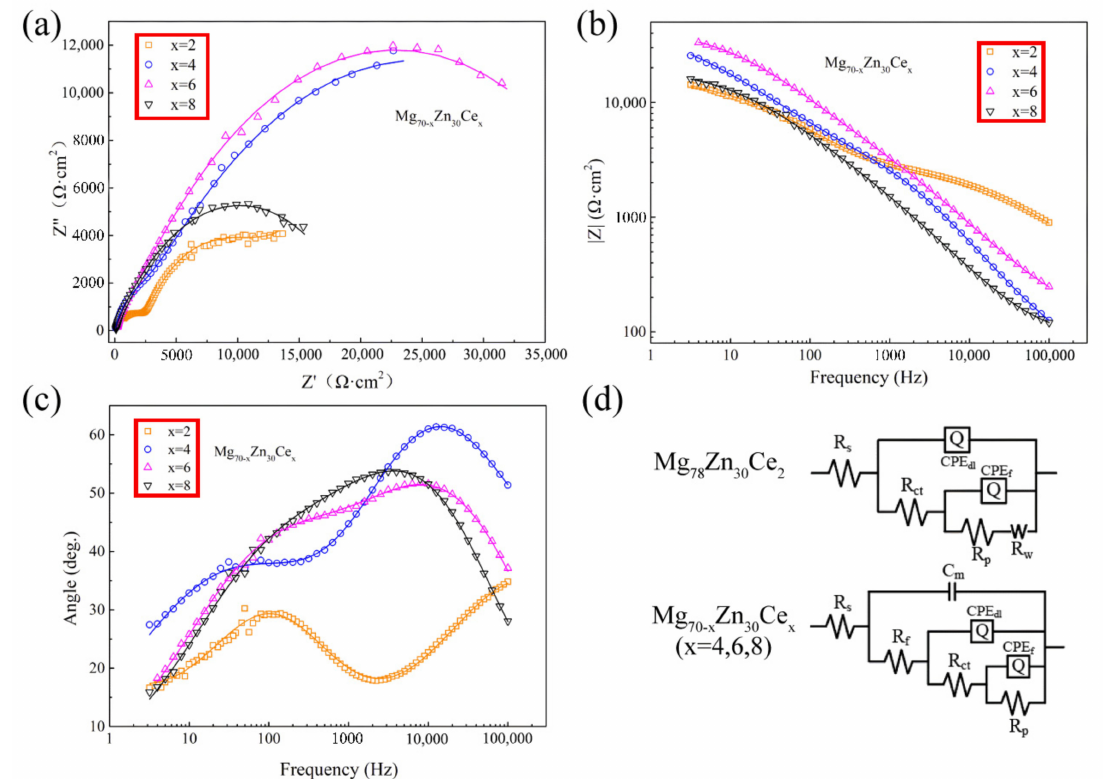
Figure 9. ( a ) Nyquist curves of the Mg 70 − x Zn 30 Ce x (x = 2, 4, 6, and 8) amorphous alloys, ( b , c ) Bode curves of the Mg 70 − x Zn 30 Ce x (x = 2, 4, 6, and 8) amorphous alloys, ( d ) equivalent circuit diagrams of the Mg 70 − x Zn 30 Ce x (x = 2, 4, 6, and 8) amorphous alloys. ZSimDemo software (3.2, AMETEK, Inc., Berwyn, PA, USA) was used to fit